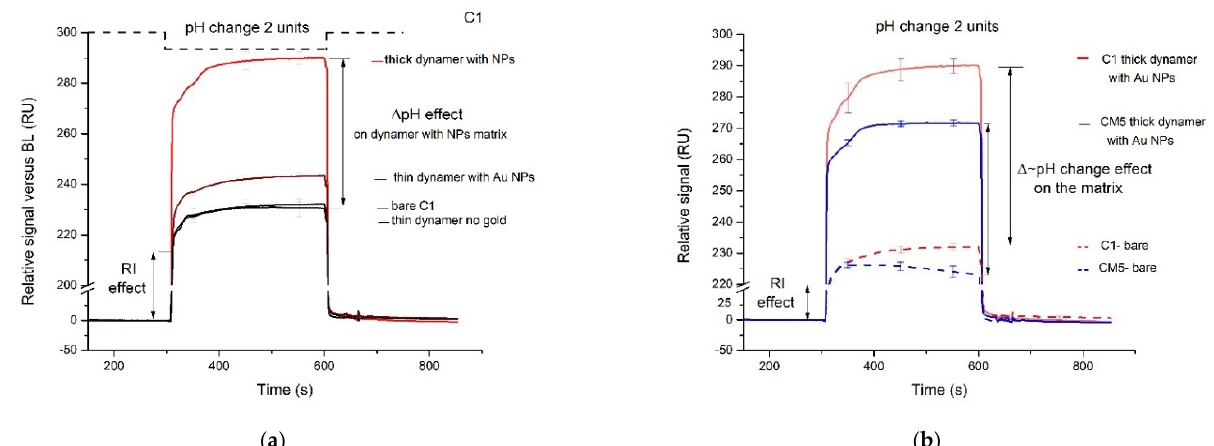
Figure 5. SPR signal of plasmonic chips with immobilized Au-DCFs, covalently bound to the surface, upon pH step changes from 7.4 to 5.5: ( a ) The effect of the Au-DCF thickness ( b ) The effect of the supporting functional layer—CM5 vs. C1 chips. pH change 2 units means passing HBS-EP buffer solution of pH 5.5 (instead of the buffer solution of pH 7.4) through the measurement chamber, for the indicated duration.